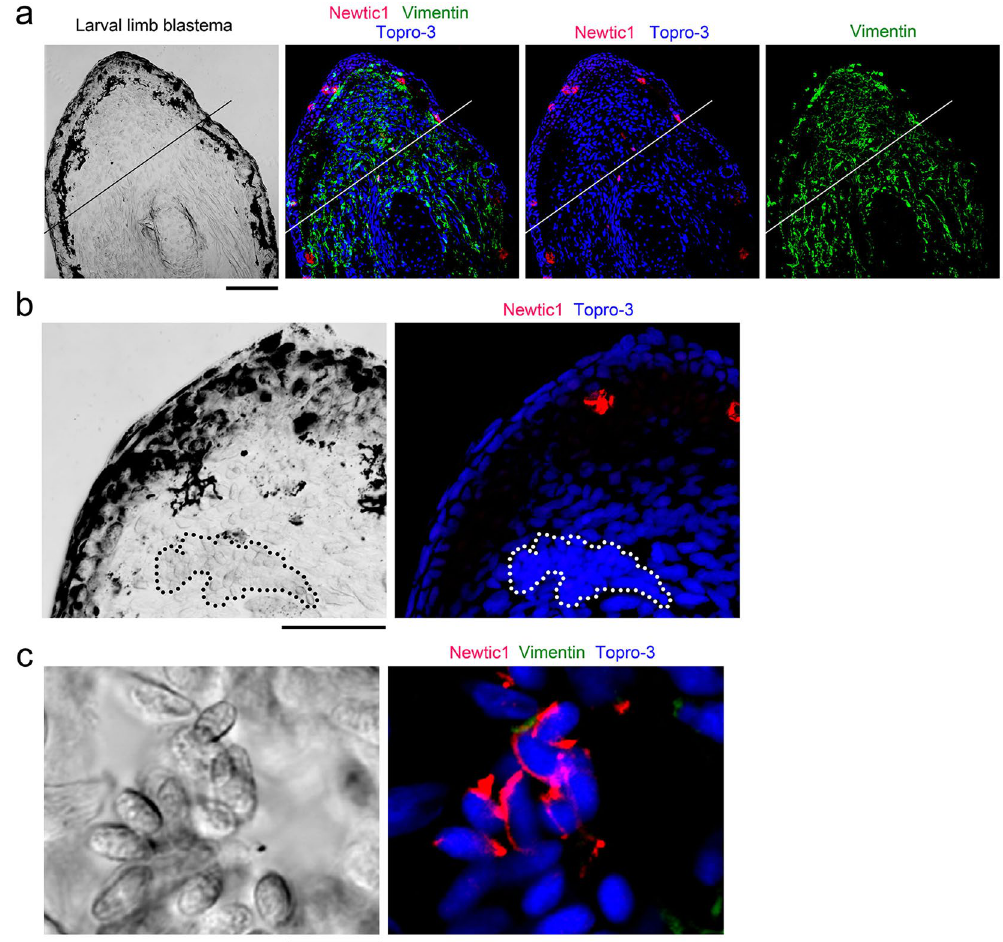
Figure 5. Newtic1-expressing erythrocytes do not contribute to larval limb blastema. ( a ) Representative image showing immunoreactivity in the blastema of the forearm in swimming larvae ~3 months old (stage 57–58; n = 3). Line: amputation plane. In contrast to adult limbs (Fig. 4), Newtic1 immunoreactivity was hardly observed in mesenchymal cells in the blastema, while a large number of fibrous cells were labeled with vimentin antibody. Note that in larval limbs, Newtic1 antibody labeled cells of gland-like structures along the skin (even on the blastema), and vimentin antibody labeled many fibrous cells similar to fibroblasts. Topro-3 (TP3): nucleus. Scale bar, 200 μ m. ( b ) A section showing a large blood vessel (dotted line) in the blastema. We were unable to find Newtic1-immunoreactive (Newtic1 + ) cells in blood capillaries/vessels in the blastema (n = 3). Scale bar, 100 μ m. ( c ) Newtic1 + erythrocytes in swimming larvae ~3 months old (stage 57–58). Larval erythrocytes (longer axis: ~15 μ m) were about half the size of those from adults. Gathering of Newtic1 + erythrocytes was rarely observed in normal blood (2 of 26 sections from 9 limbs). These cells were not associated with either vimentin-immunoreactive cells or cells such as monocytes. Scale bar, 100 μ